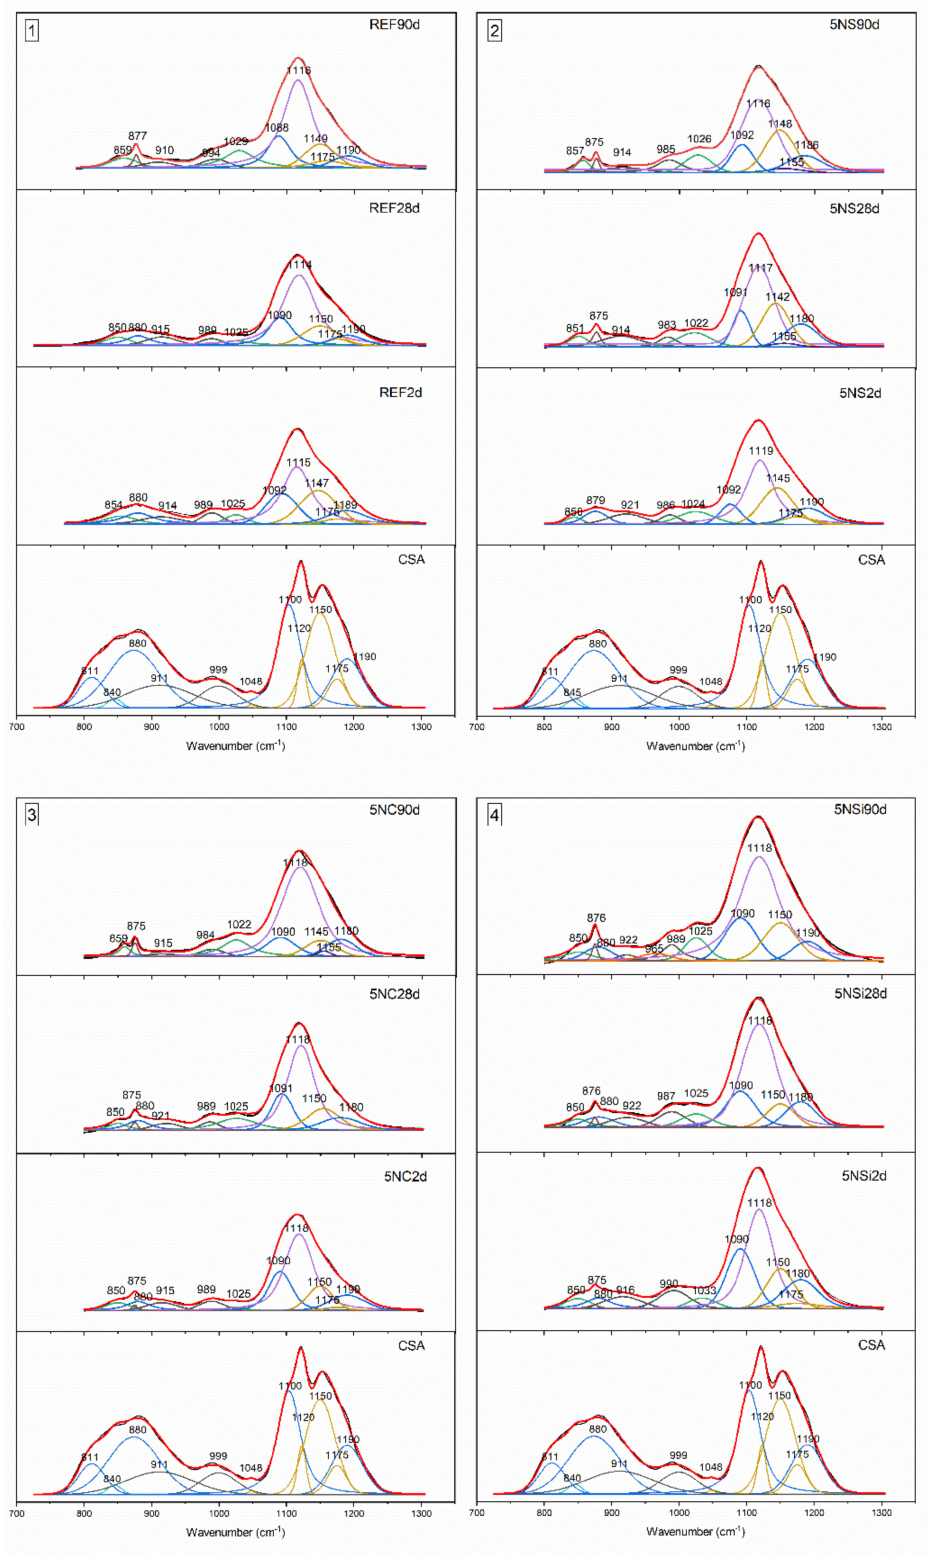
Figure 5. Deconvoluted 2-, 28-, and 90-d spectra (1350 to 700 cm − 1 range) for CSA hydrated with water and alkaline salts; legend: blue: —/ye’elimite; yellow—C$; grey—C 2 S; green—AH 3 ; violet -ettringite; brown—CaCO 3 ; burgundy—strätlingite; purple—thenardite; lime—C 3 A, red—cumulative